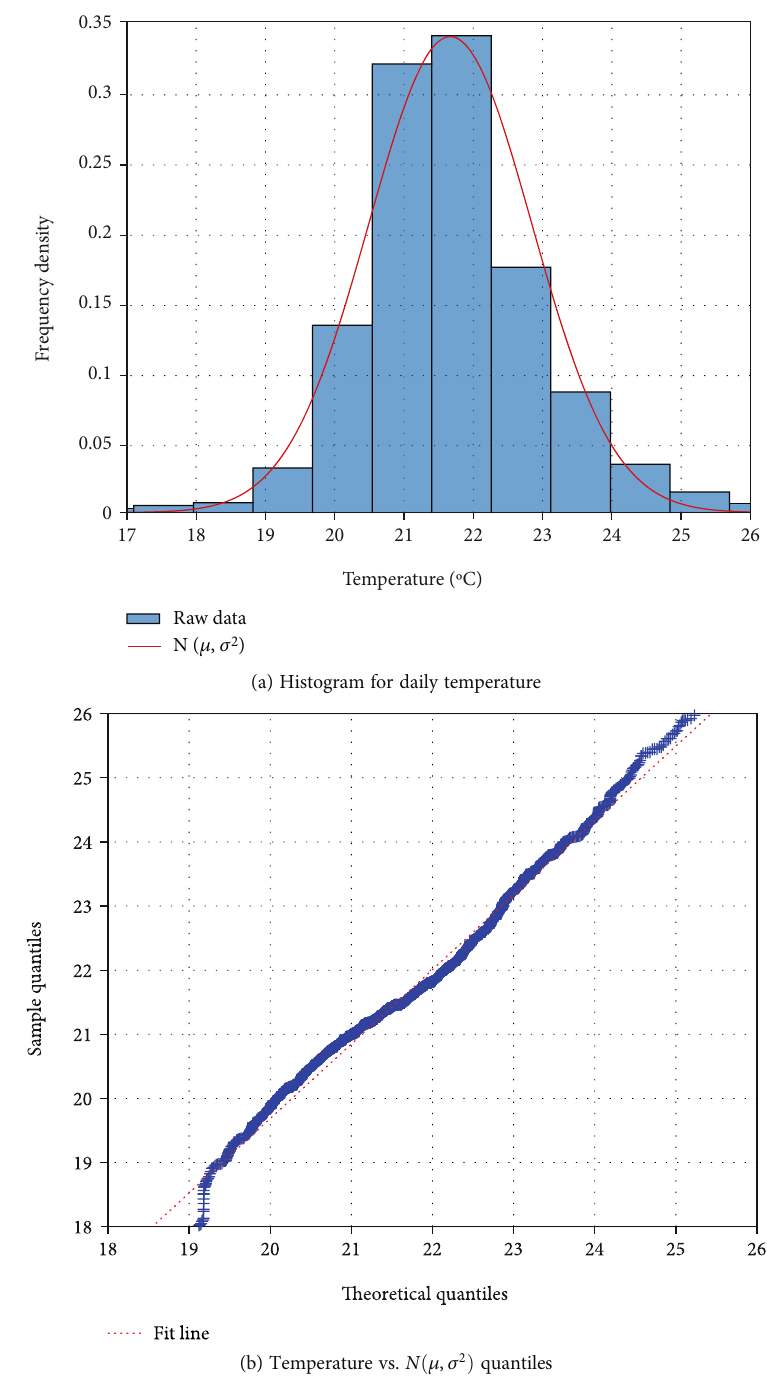
Figure 3: Probability density of daily temperature for Chitedze. Table 1: Kolmogorov test.